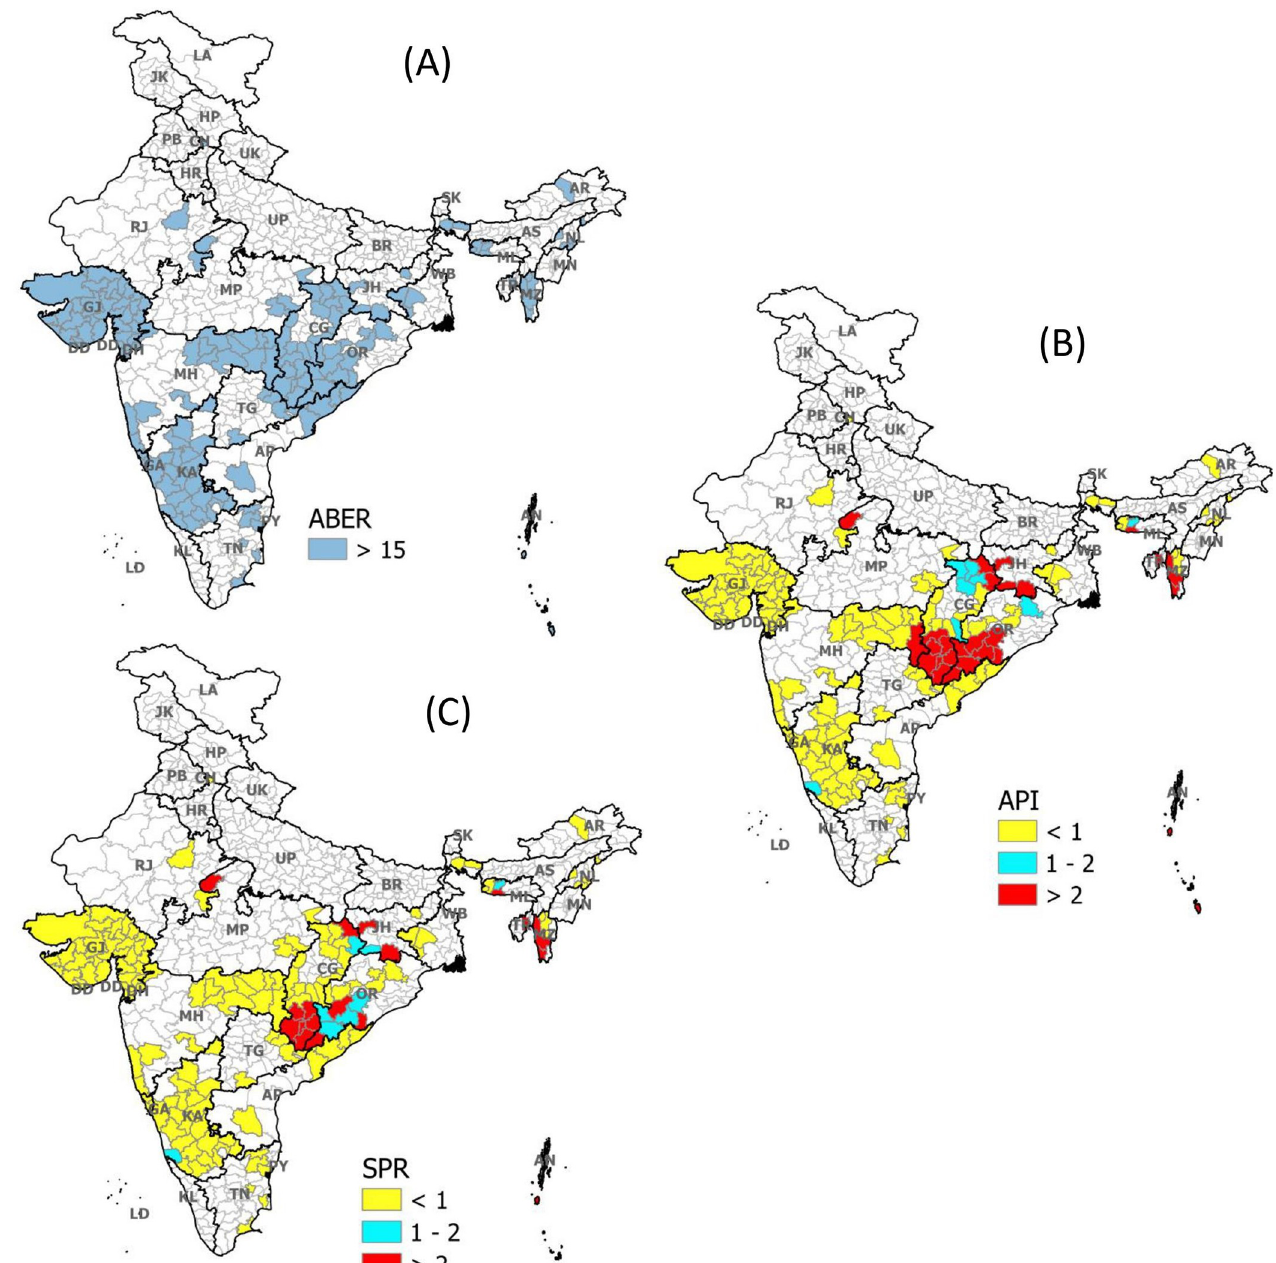
Fig 4. Distribution of API and SPR among high surveillance districts of India. (A): Representing all districts (blue shaded) of India where ABER > 15 (Strata 3) (B): Distribution of API as per NSP in these districts (Strata 3) (C): Distribution of SPR as per NSP in these districts (Strata 3). ABER: Median Annual Blood Examination Rate across three years (2017–19); API: Median Annual Parasite Incidence across three years (2017–19); SPR: Median Slide Positivity Rate across three years (2017–19); NSP: National Strategic Plan 2017–22. to lower ABER, API [Median (P25 to P75): 0.16 (0.07 to 0.16)] values were found significantly lower (p-value < 0.001) than the SPR values [Median (P25 to P75): 0.32 (0.08 to 0.73)]. Similar to low surveillance (ABER < 5) states, there were many states wherein most districts had a three-year average ABER of > 15% such as Gujarat (Median (p25 to p75): 23.2 (20.6 to